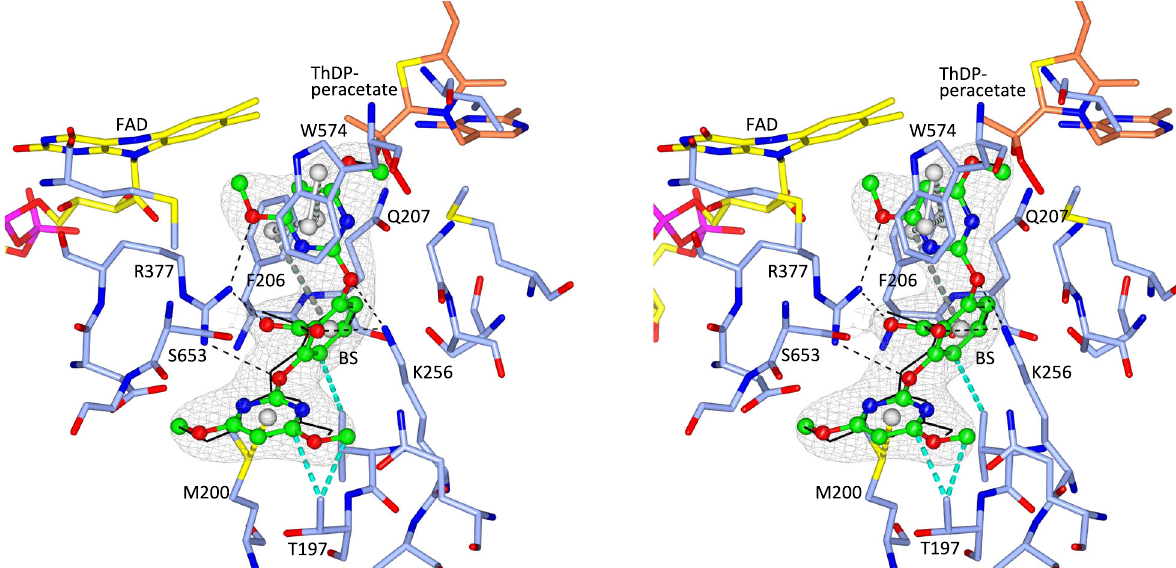
Fig. 8 Stereoview of the herbicide binding site in the P197T-BS complex. The At AHAS polypeptide is in light blue. FAD, ThAThDP, and BS are in yellow, light brown, and green carbon atoms, respectively. The black thin lines represent BS in the WT At AHAS-BS structure that has been superimposed to the P197T-BS structure. Electron densities (2F o -F c map) in gray correspond to BS contoured at 1.2 σ . The interaction representations are as in Fig. 7. Grey dashed cylinders represent π – π interactions. Yellow dashed cylinders represent sulfur – π interactions. Blue dashed cylinders represent hydrophobic interactions. Dashed lines represent hydrogen bonds